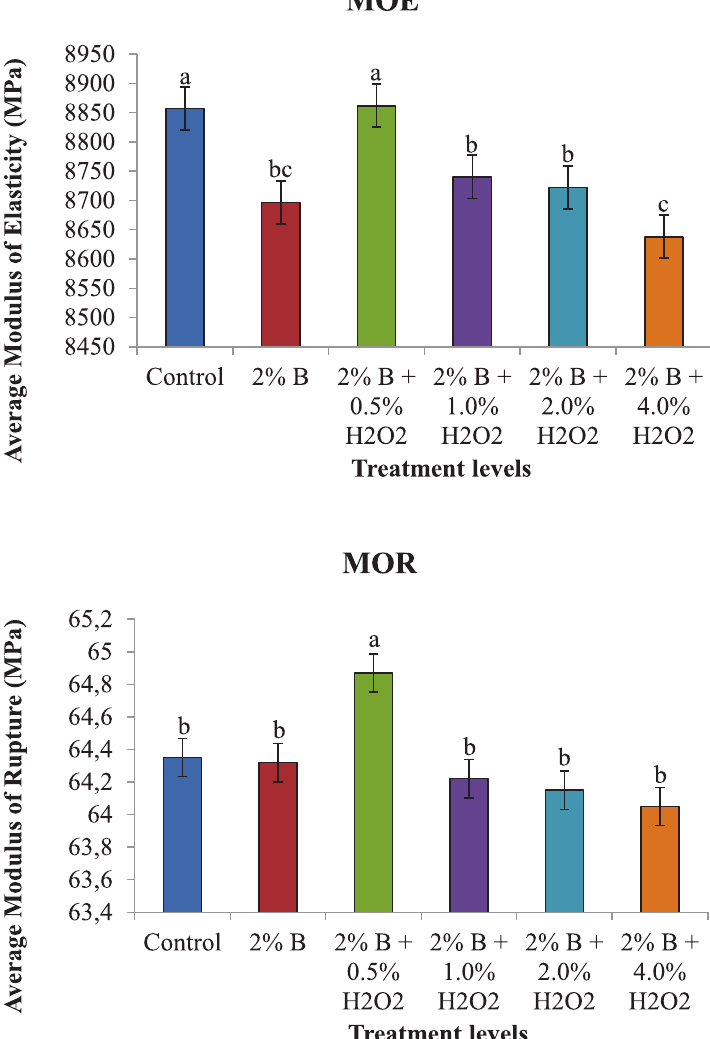
Figure 2 - Average static bending (top = modulus of elasticity and bottom = modulus of rupture) of bleached rubberwood at different treatment level. means within column followed by the same letter are not significantly different at the 5% level of anOva test. Error bar represents the standard